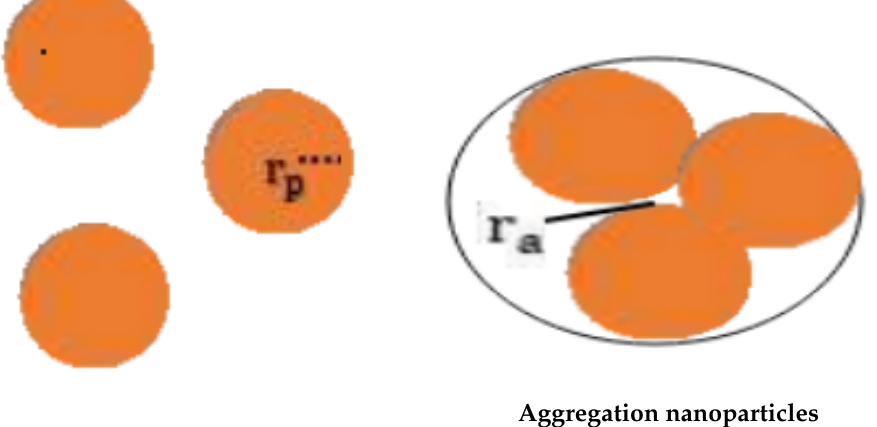
Figure 1. Nanoparticles aggregation where r a and r p radii of the aggregated nanoparticles and single nanoparticles